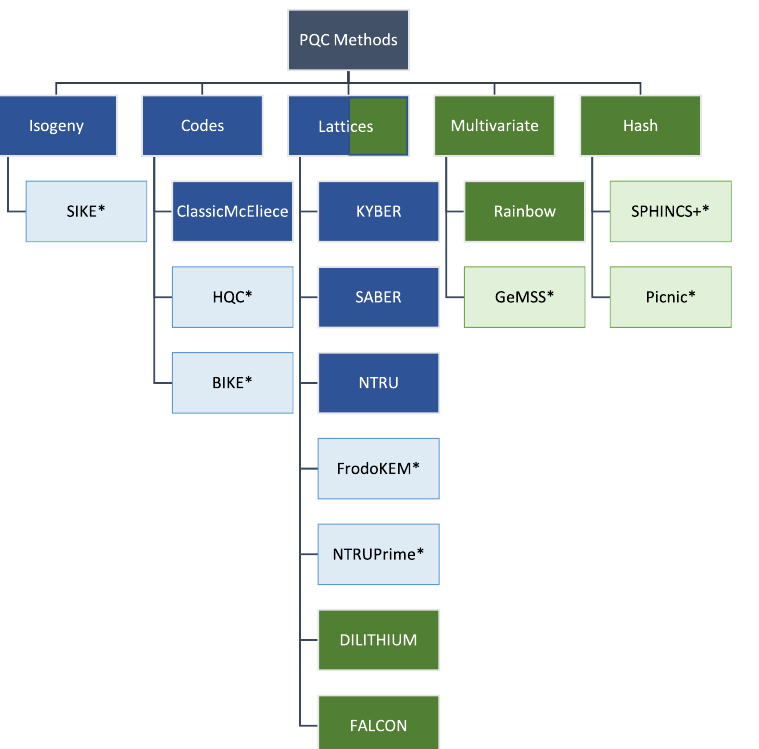
Figure 4. PQC algorithms that are currently considered for standardization in the associated NIST process. KEMs are marked with blue-colored boxes and DSAs with green-colored boxes. Asterisks and lower opacity indicate alternate